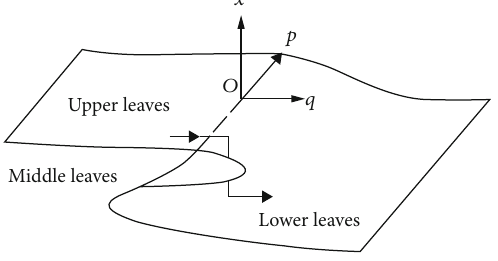
Figure 8: Catastrophe equilibrium